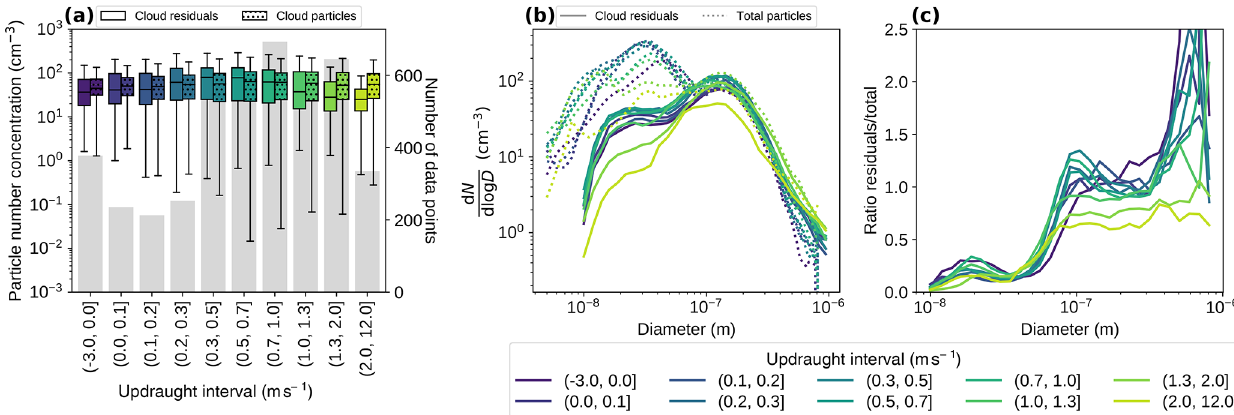
Figure 5. In-cloud data binned by updraught. (a) Box plot of cloud residual (solid) and cloud particle (hatched) number concentrations for different updraught intervals (see legend). The whiskers extend to the farthest points that are within 1.5 times the interquartile range from the nearest quartile. Points that fall outside the whiskers are not shown. The grey bars in the background indicate the number of cloud residual data points (right y axis) per updraught bin. (b) Mean particle number size distributions of cloud residuals (solid) and total particles (dotted) for different updraught intervals (see legend). (c) Ratio of the size distributions in (b) , i.e. cloud residual concentrations divided by total particle concentrations. Only data collected at temperatures > 0 ◦ C are shown in this